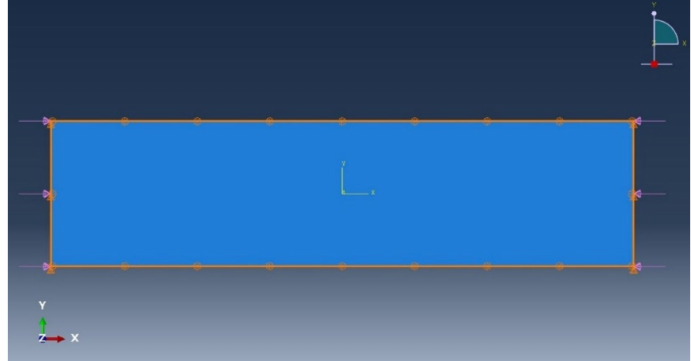
Figure 5. Proposed model for verification study using ABAQUS.